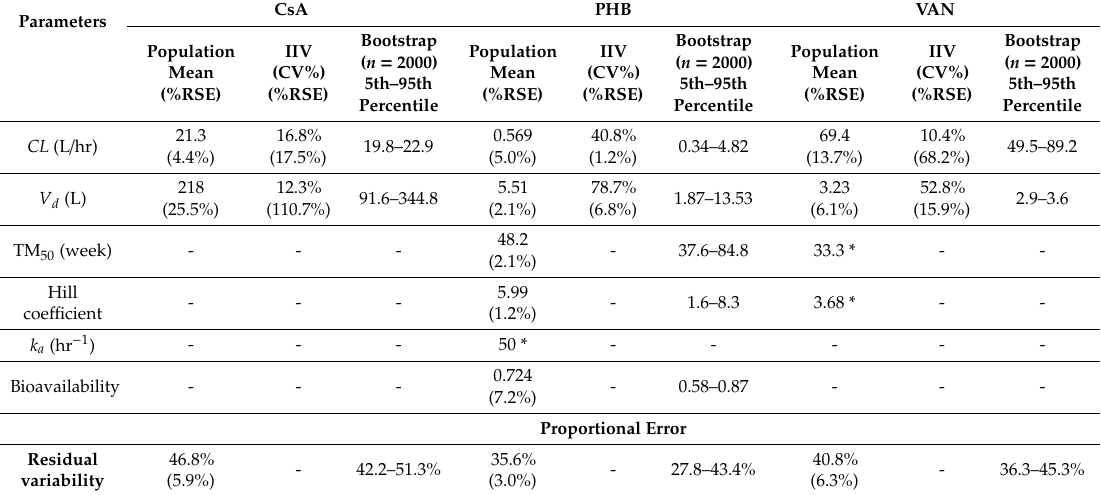
Table 3. Estimated parameters from the final model and bootstrap results for cyclosporine A (CsA), phenobarbital (PHB) and vancomycin